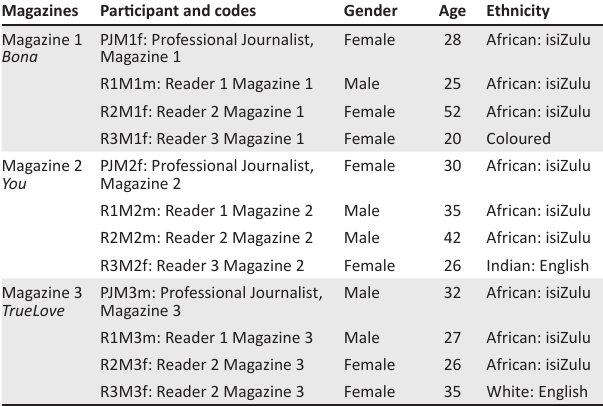
TABLE 1: Participants’